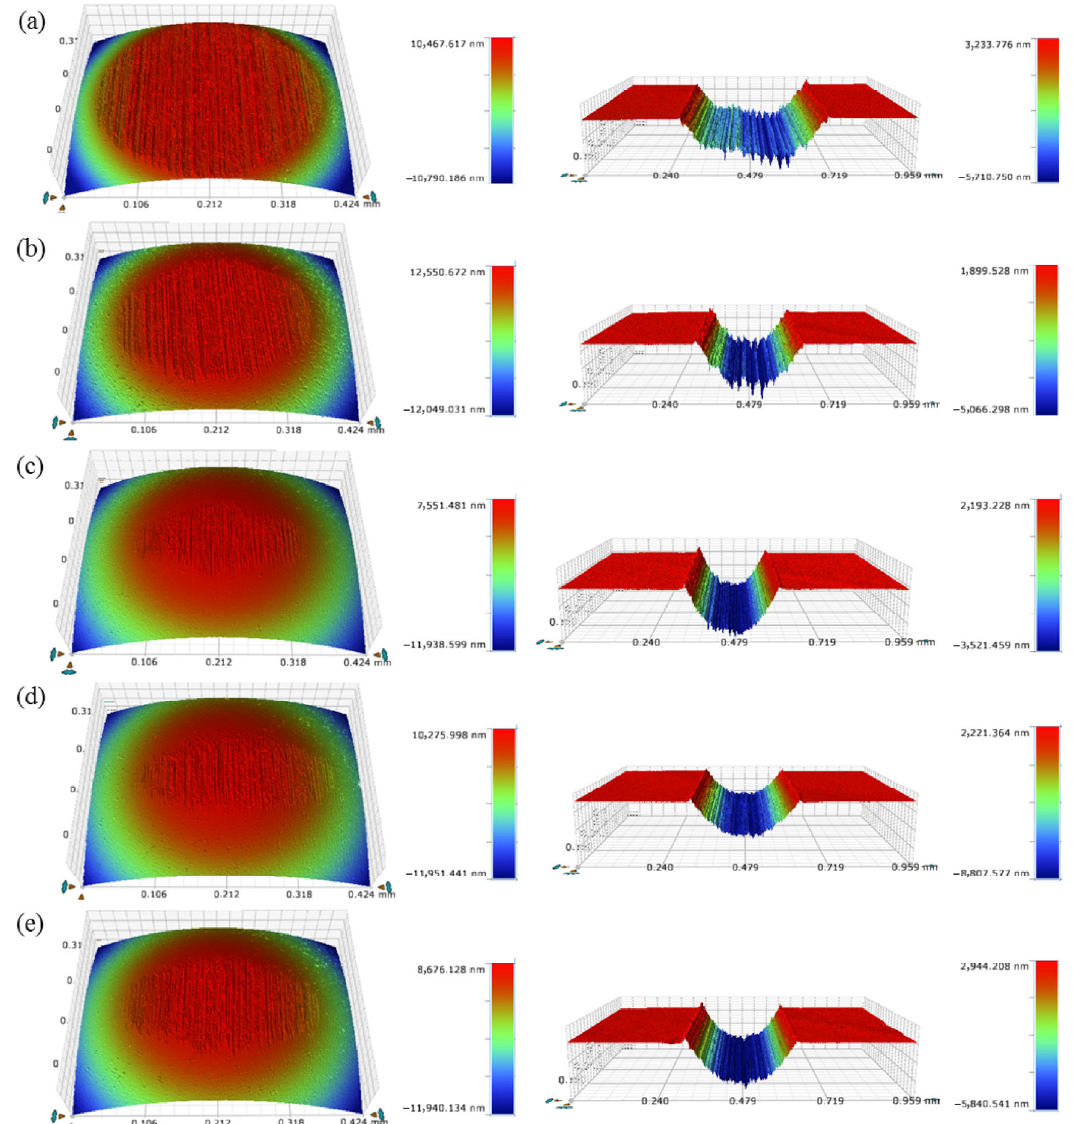
Fig. 9 The 3D morphologies of the worn surface on Si 3 N 4 ball (left) and 304 stainless steel plate (right) lubricated by (a) distilled water, (b) commercial water-base lubricants, (c) 0.8 wt% CuO nanobelts, (d) 0.8 wt% CuO nanorods, and (e) 0.8 wt% spindle CuO nanostructures (speed: 0.02 m/s, load: 2.0 N, time: 30